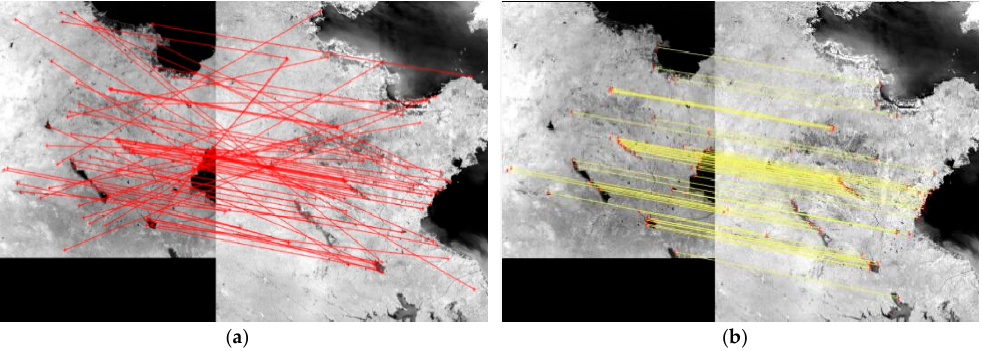
Figure 2. Coarse matching result. ( a ) The coarse matching result by SIFT; ( b ) The coarse matching result by SR-SIFT.